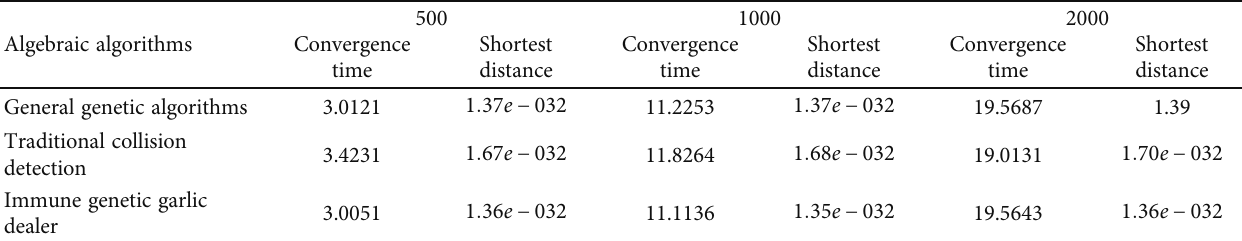
Table 2: The simulation results of the algorithm with 200, 400, and 800